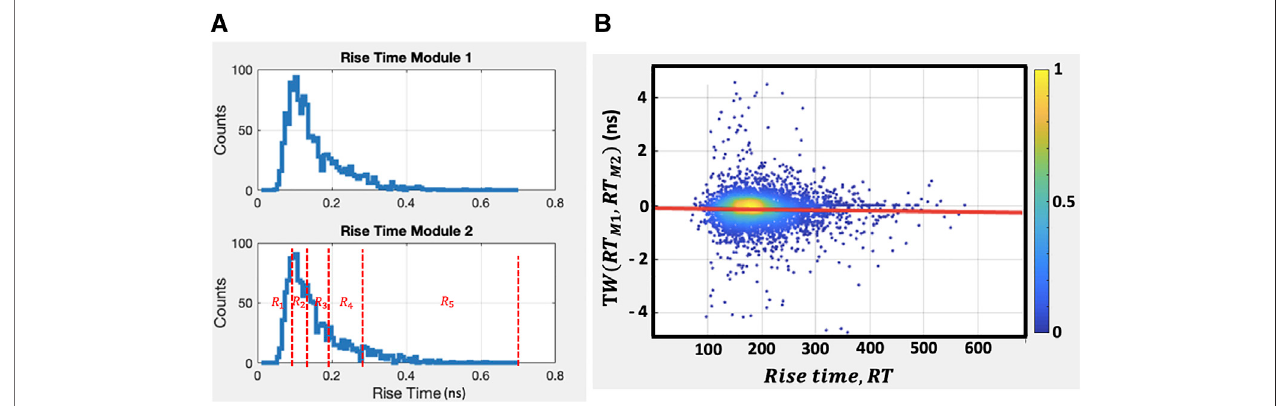
FIGURE 4 | (A) . Measured rise time histograms for 3 × 3 × 3 mm 3 BGO crystals. The bottom histogram shows an example of the data splitting into fi ve different regions(eachcontaining20%oftheevents),